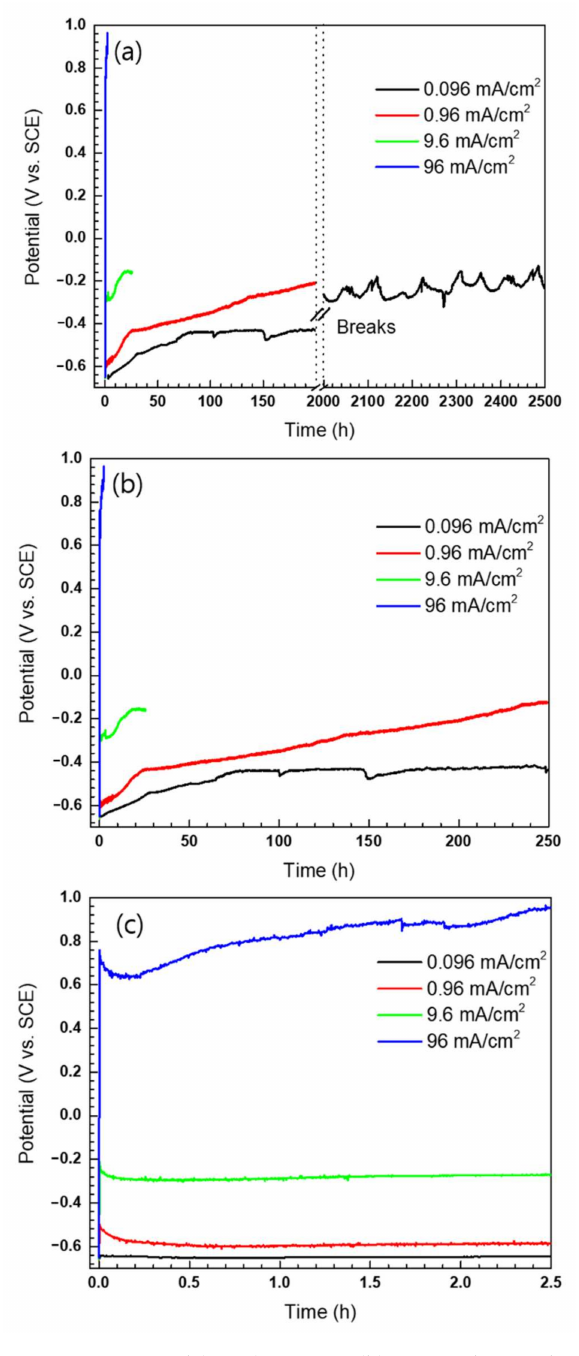
Figure 2. Potential (V SCE ) vs. time (h) curves during the GS test at 60 ◦ C. The shape of the graph follows the Sand equation. ( a ) Entire curves with breaks; ( b ) graph from 0 to 250 h; ( c ) graph from 0 to 2.5